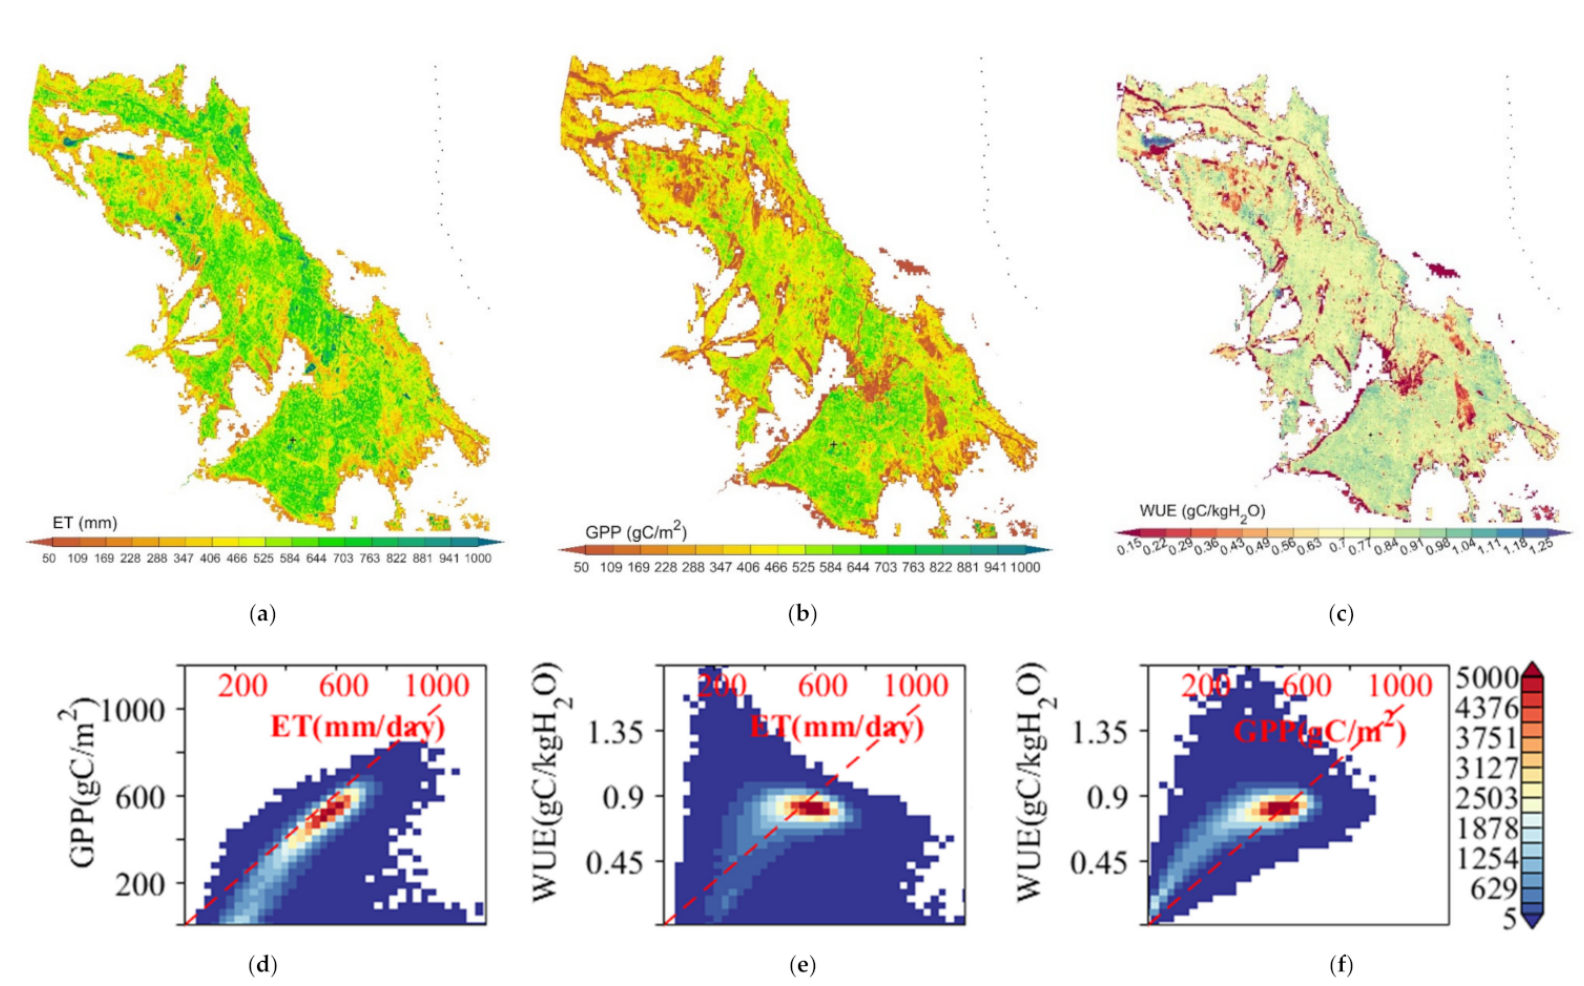
Figure 9. Spatial distribution of annual ( a ) ET, ( b ) GPP, and ( c ) WUE, and bivariate histograms (count) between ( d ) ET and GPP, ( e ) ET and WUE, and ( f ) GPP and WUE over midstream oasis agricultural areas. Black plus sign indicates location of DMS. Data from 2013 were selected as an example of detailed spatial distribution